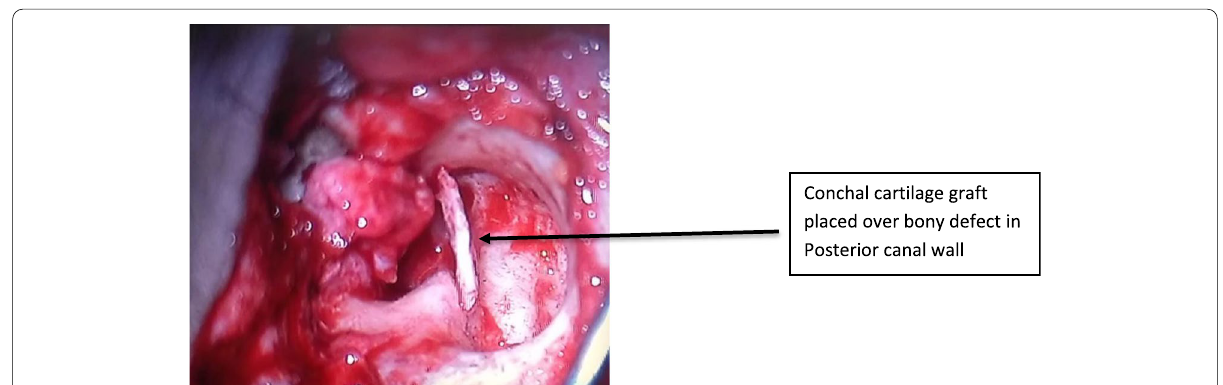
Fig. 2 Intraoperative picture after reconstruction of posterior canal wall using conchal